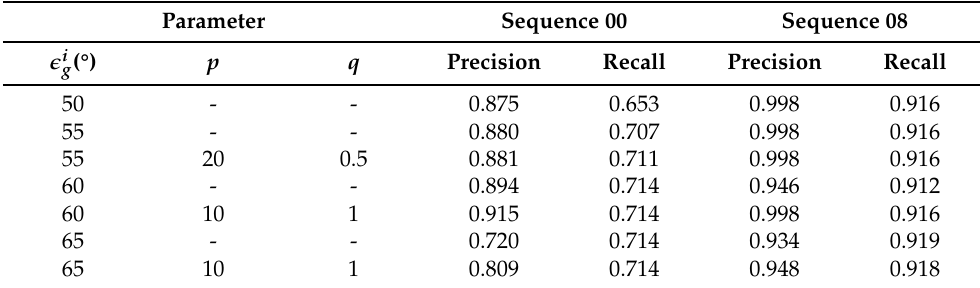
Table 2. Precision and recall rates of different (cid:101) g , p and q .